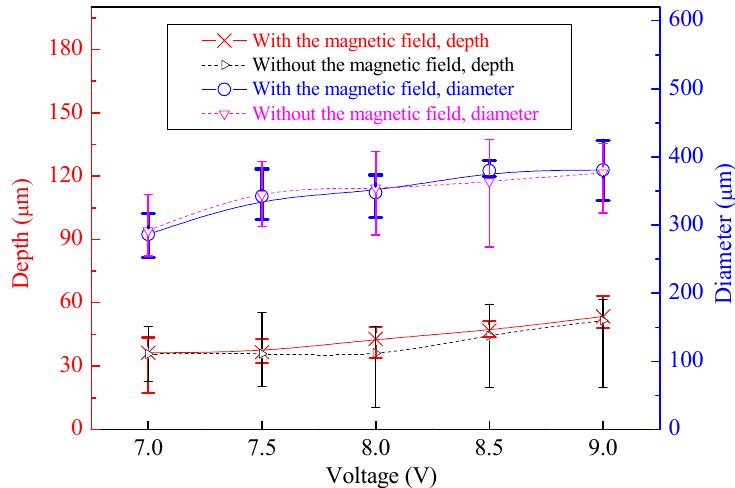
Figure 6. Change in dimensions of machined arrayed micro ‐ dimples with the applied voltage and with or without magnetic field (single ‐ travel time of 0.3 s).